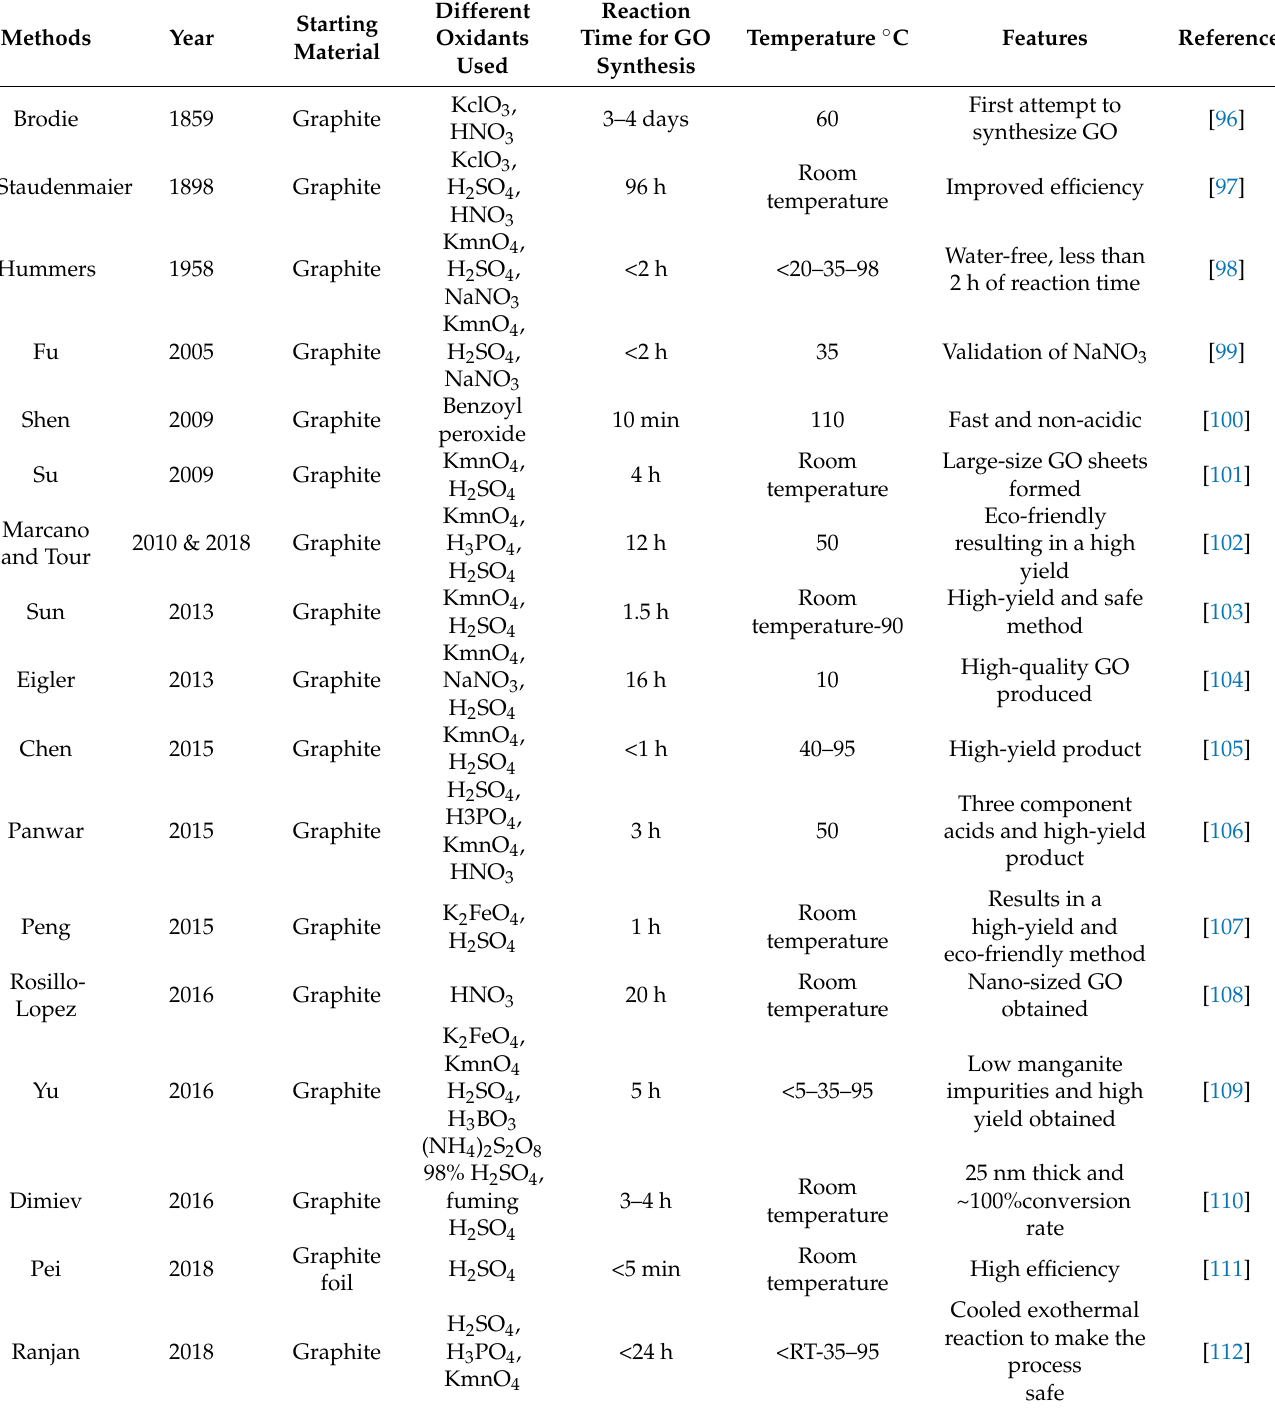
Table 2. List of different methods used to synthesize graphene